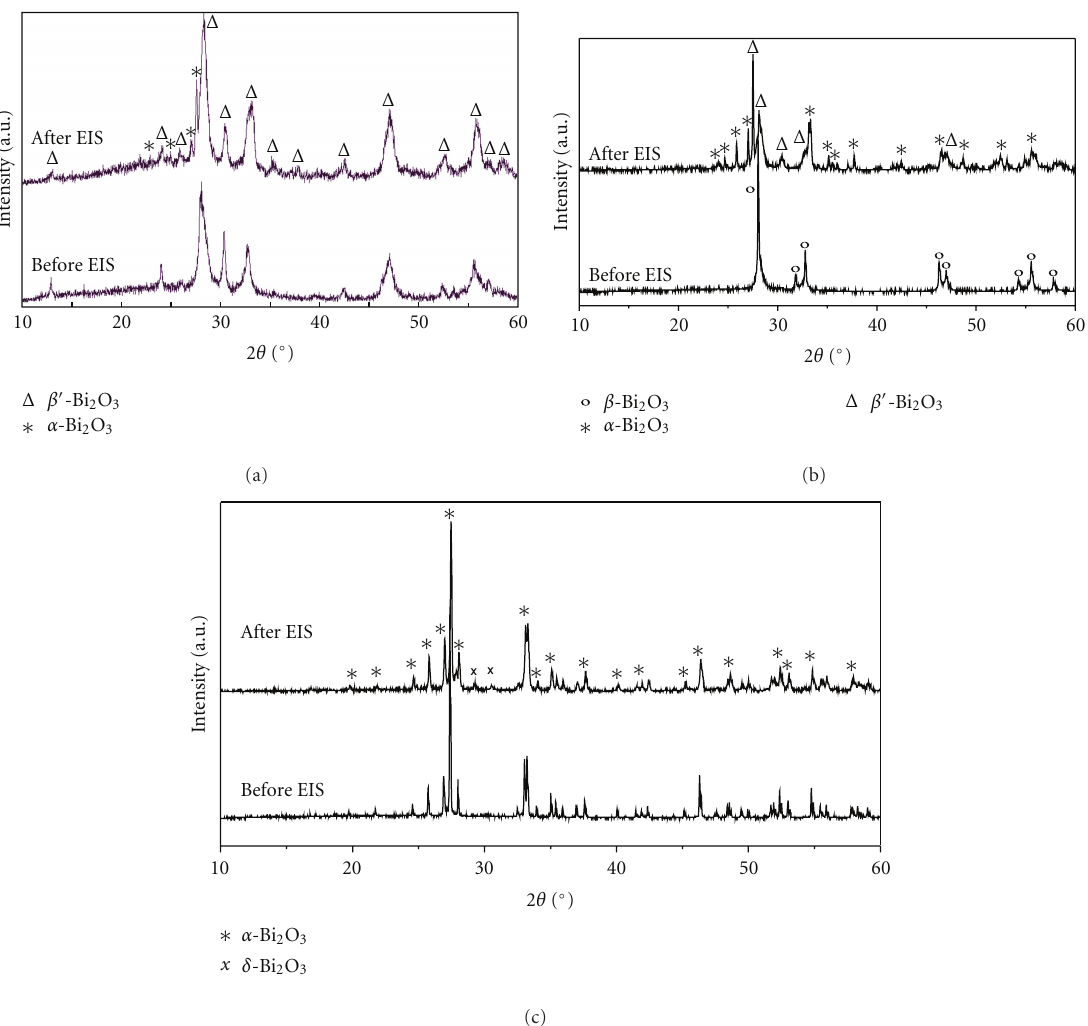
Figure 2: XRD patterns ( λ cuK α 1 = 1 . 54 × 10 − 10 m) before and after EIS experiments. (a) x = 0 . 7 (phase β (cid:4) ); (b) x = 0 . 8 (phase β ); (c) x = 1 (phase α